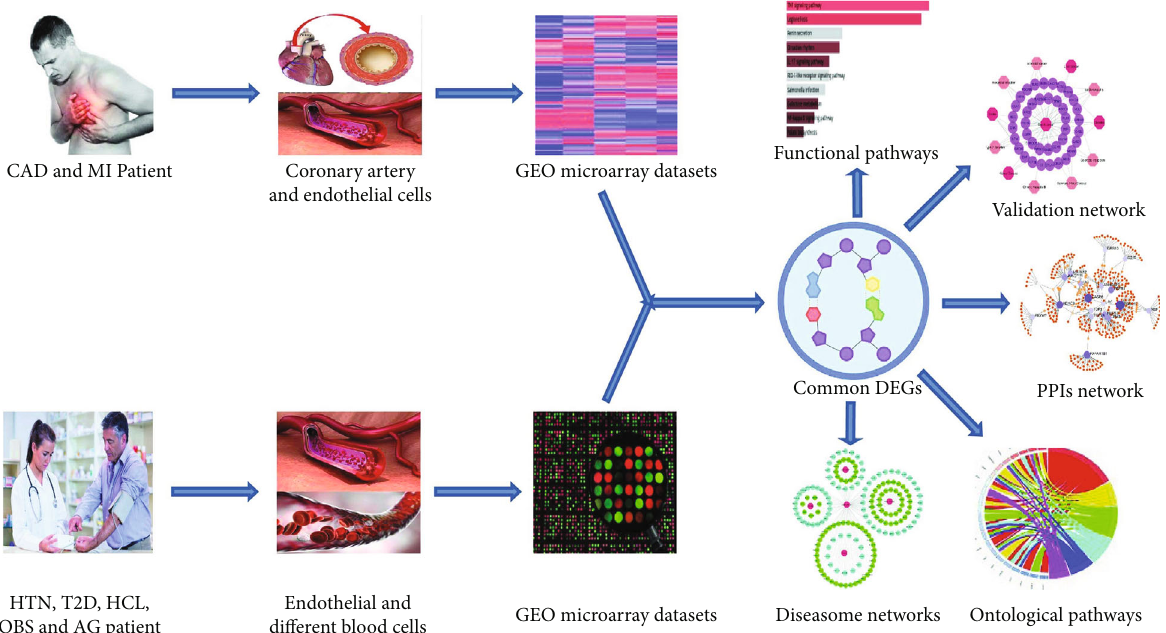
Figure 1: Block diagram of the applied analytical